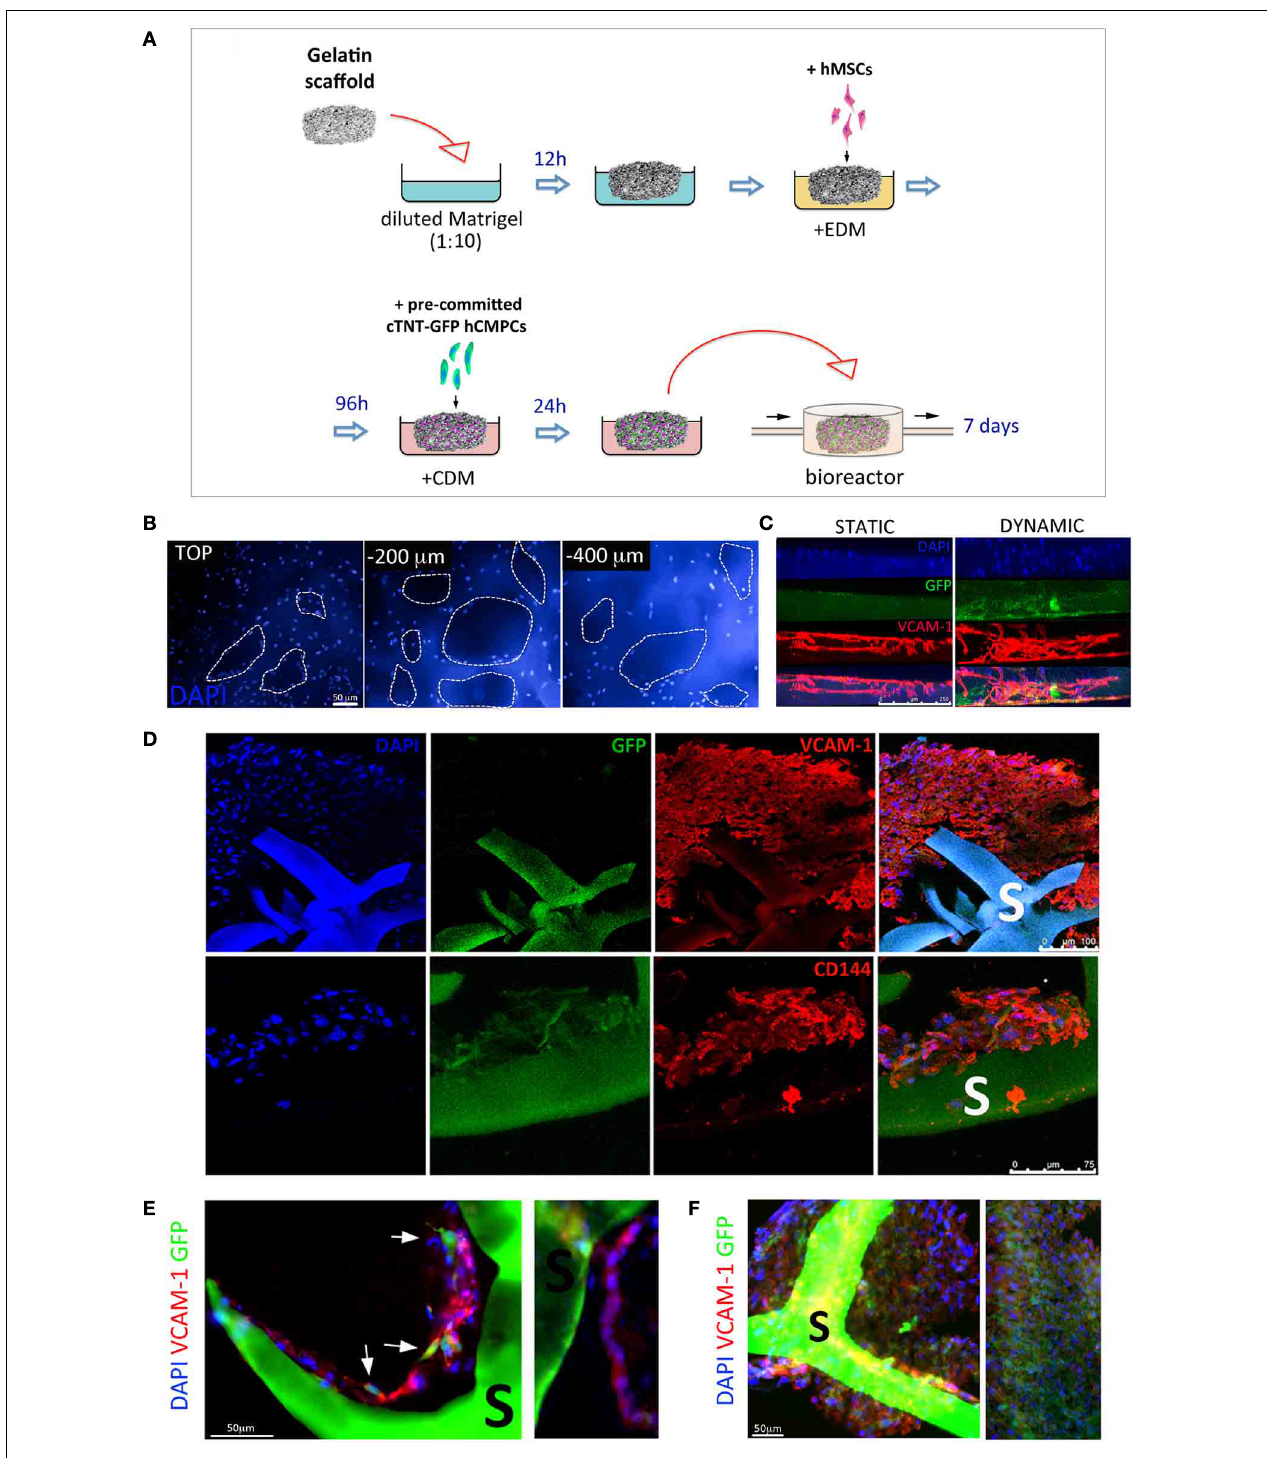
FIGURE 6 | Generation of a vascularized 3D cardiac construct by adult stem cells grown in dynamic conditions onto gelatin porous scaffolds. Schematic illustration of the protocol used to produce vascularized 3D cardiac construct (A) . Gelatin porous sponges were dipped in diluted Matrigel™ and then switched to endothelial differentiation medium (EDM). Therefore,